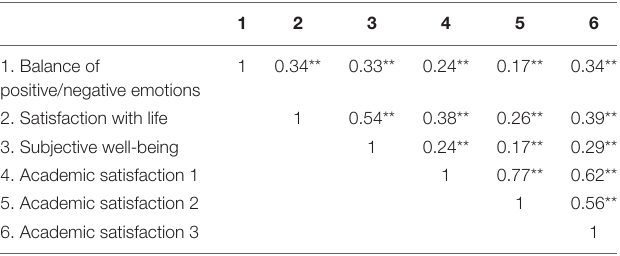
TABLE 2 | Bivariate correlations between the variables comprising the subjective well-being model.